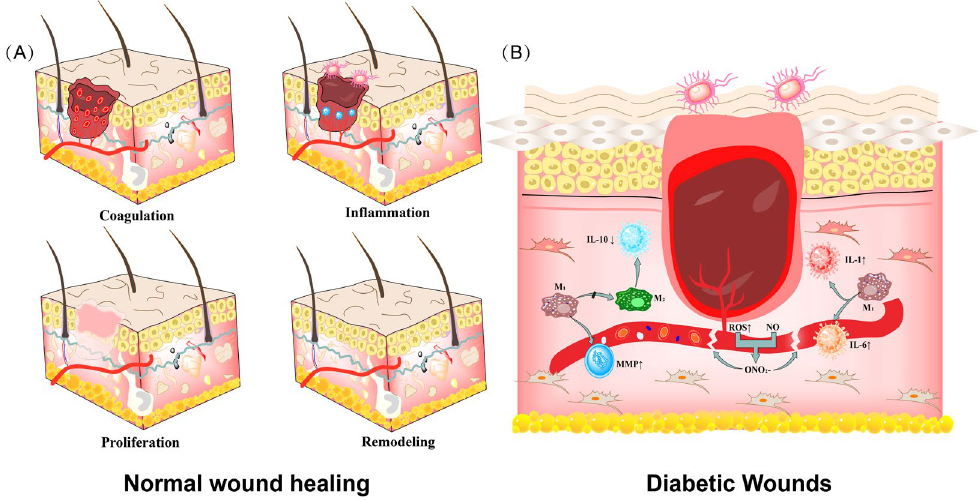
Figure 3. ( A ) Diagram of the normal wound healing process. ( B ) Diabetic wounds with overexpres- sion of inflammatory factors. ROS reacts with NO to create peroxynitrite (ONO 2 − ) in a high-glucose environment, impairing